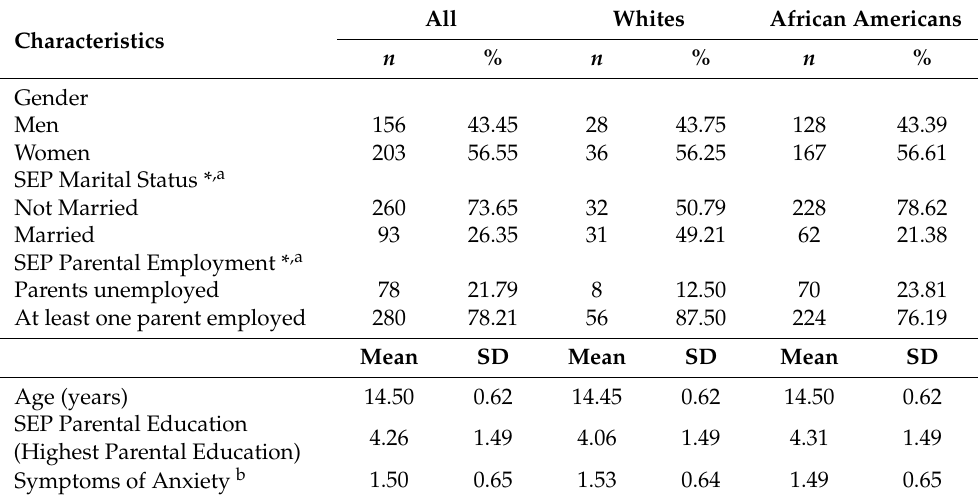
Table 1. Descriptive statistics in the pooled sample and by